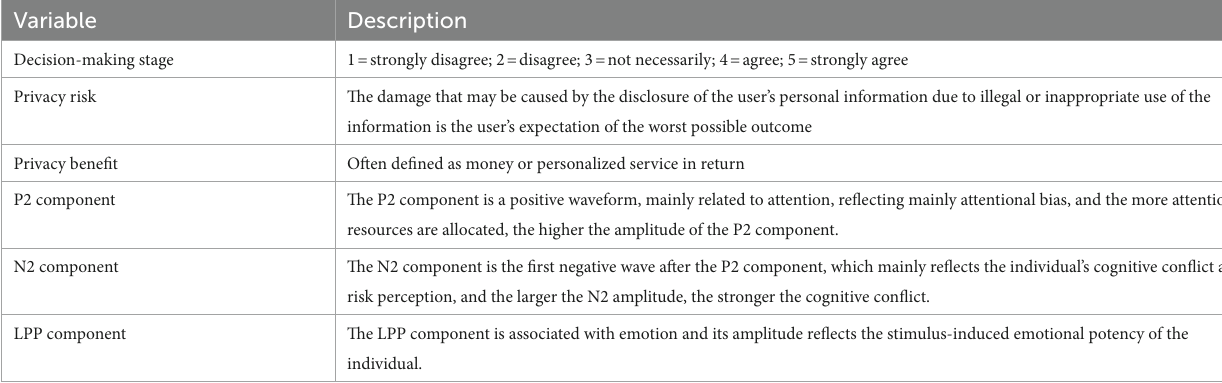
TABLE 1 Description of relevant test